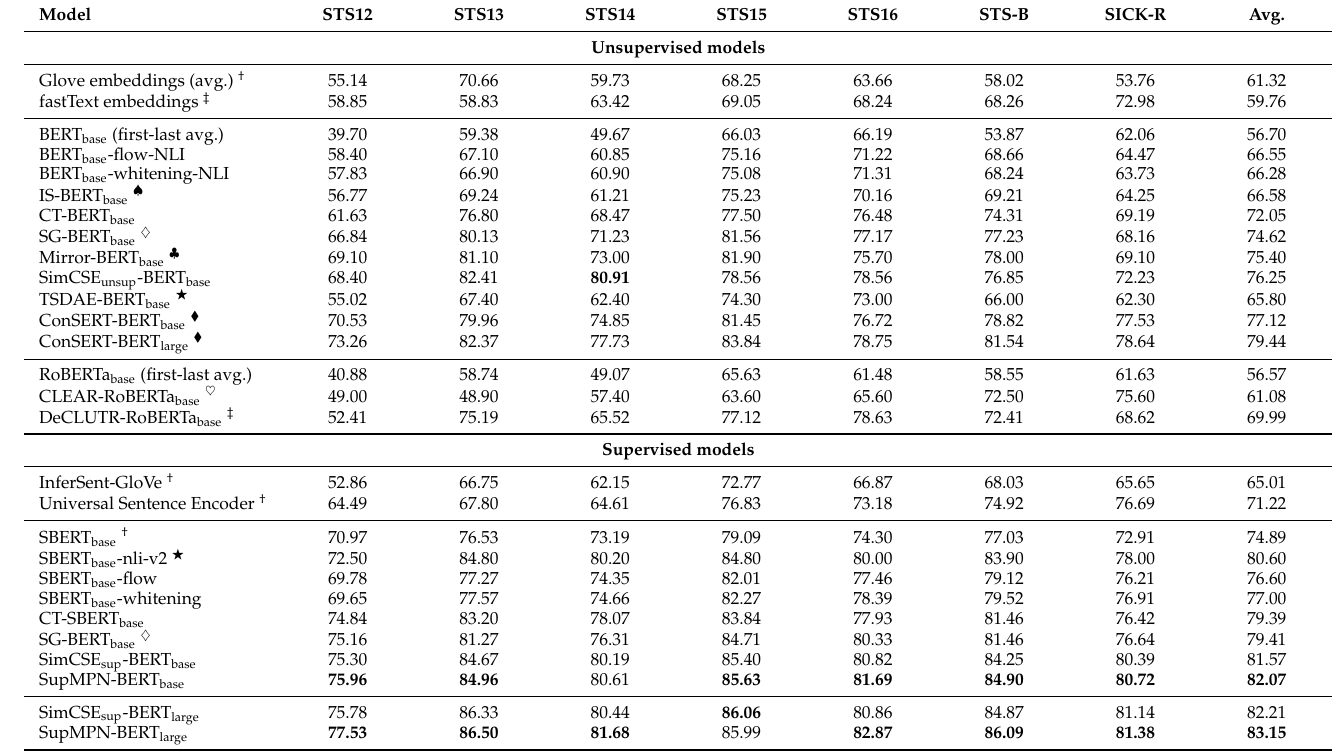
Table 2. Experimental results on STS tasks. We report Spearman’s rank correlation as ρ × 100. The best result in each column is in bold. †: [52], ‡: [35], ♠ : [56], ♣ : [36], (cid:70) : [73], (cid:7) : [16], ♥ : [33], ♦ : [34], and all the other results are from